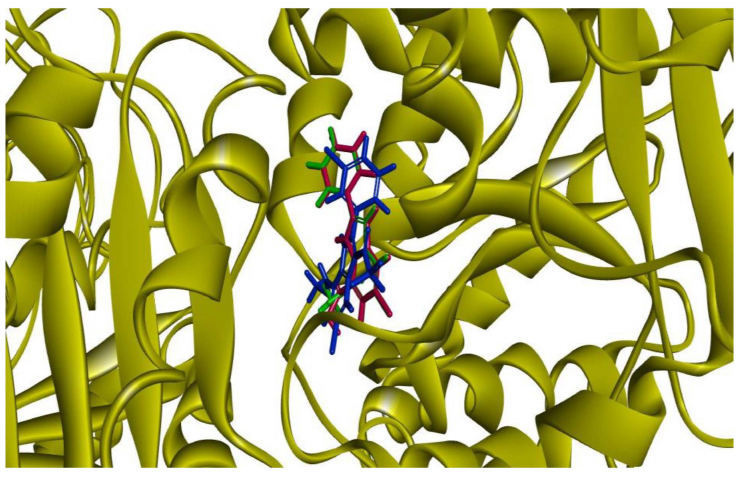
Figure 5. Compounds 2a (green), 4a (pink) and 5g (blue) were docked at the interface of a tubulin heterodimer (PDB code: 1TUB), which is coloured